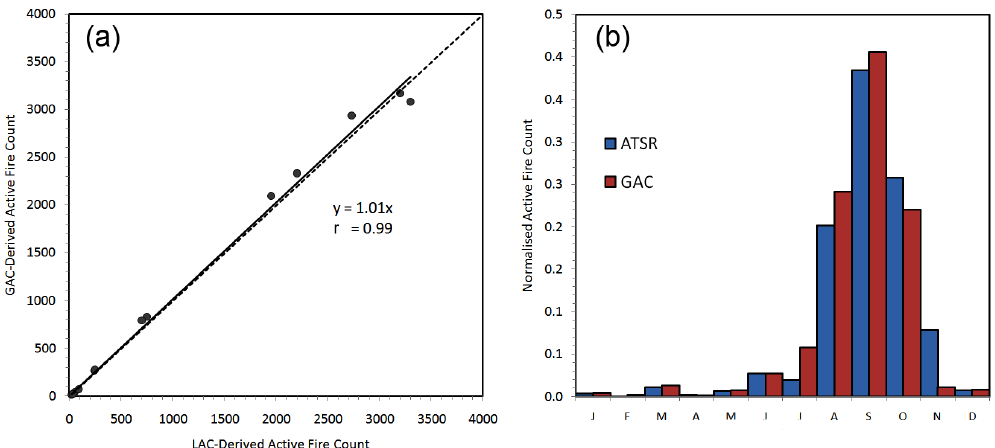
Fig. 6. Comparison of the active fire (AF) pixel count for Borneo derived for the 1997 El Ni˜no period. (a) Comparison between AF pixel counts derived from GAC and LAC versions of the same thirteen AVHRR scenes (examples of which are shown in Fig. 3b and c). The 1:1 line is also shown. (b) Temporal trend in the normalised AF pixel count for the 1997 El Ni˜no period, derived via the AVHRR GAC processing described herein and from the widely used ATSR World Fire Atlas (Schultz, 2002; Mota et al., 2006). Strong similarities are evident in all